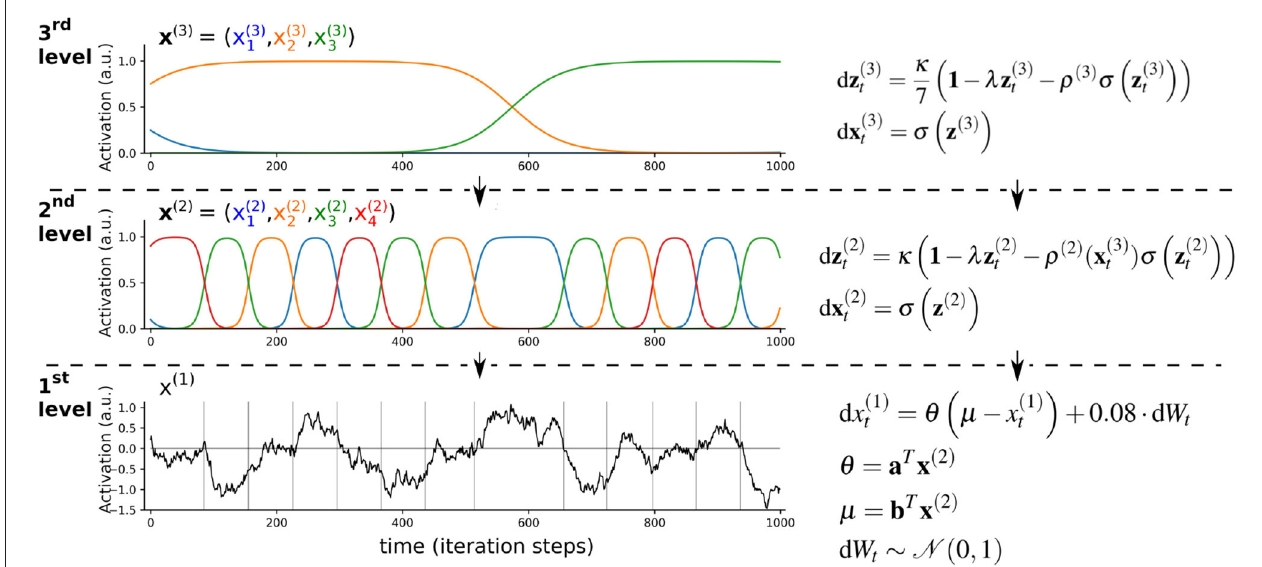
FIGURE 6 | Illustration of hierarchical continuodiscrete dynamics based on limit cycles. Slowly changing dynamics at the 3rd level parametrize the sequence of states of the faster changing 2nd-level dynamics z (2) . As the dynamics of variables E x (2) and E x (3) change between the states “on” and “off,” their behavior constitutes continuodiscrete WLC dynamics. At around iteration step 600, the green unit at the 3rd level (element E x (3) 3 ) becomes active, which changes the 2nd-level sequential dynamics from red → green → orange → blue → red to green → orange → red → blue → green. This is achieved by a change of the 2nd-level connectivity matrix ρ (2) which depends on the 3rd-level variable E x (3) . In this toy example, the 2nd-level dynamics model the evolution of the parameters of an Ornstein-Uhlenbeck process (black graph showing the evolution of variable x (1) ). In the framework of hierarchical generative modeling, the 1st level would correspond to an agent’s predictions of its sensory input, while the higher levels are the hidden states of the agent’s generative model. This hierarchical parametrization of sequences is similar to the approach in Kiebel et al. (2009). The dot product between vectors b = (0.6,0, − 1, − 0.3) T and E x (2) determines the 1st-level attractor µ . The rate parameter 2 is parametrized by vector a = (1,0.5,1.2,0.8) T and its dot product with E x (2) . σ ( · ) is the softmax function which is applied element-wise. 1 denotes a vector of ones. κ = 2, λ = 1 / 8. Gray vertical lines in the 1st level mark the time-points where states in the 2nd level change. This hierarchical parametrization of sequences is similar to the approach in Kiebel et al. (2009). Similar hierarchical autonomous models can be used as a generative model for Bayesian inference to achieve prediction and recognition of sequential data, as has for example been done in Yildiz and Kiebel (2011) and Yildiz et al.